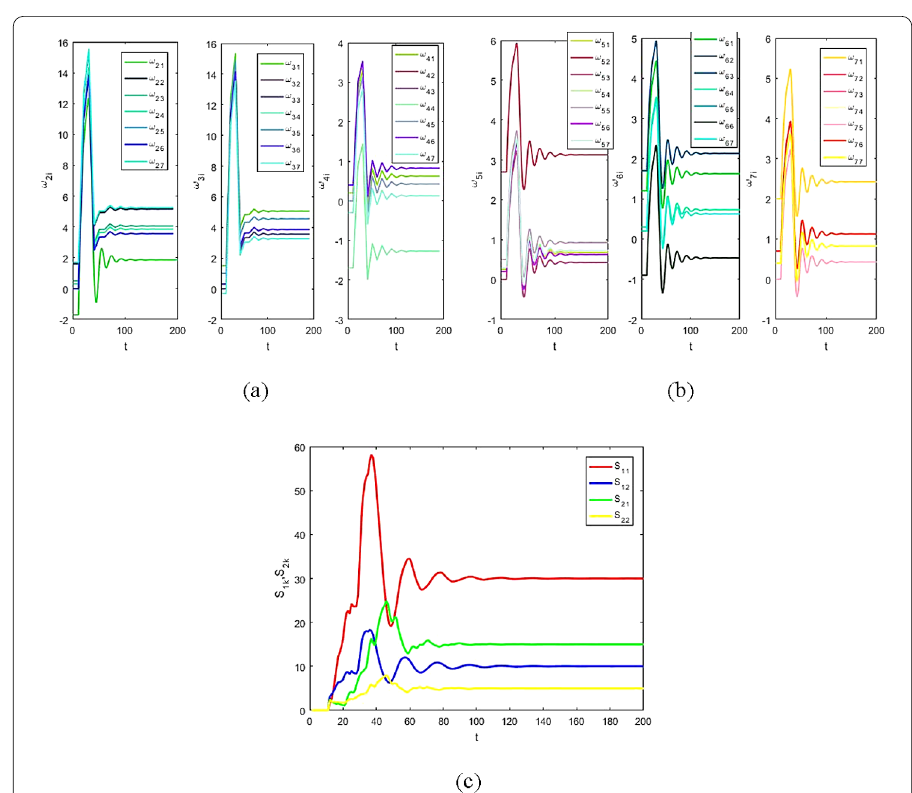
Figure 8 (a) , (b) : Identification process for the adjustment parameter ω ij ( i , j = 2, ... ,7); (c) : state trajectories of S 1 k ( t ) and S 2 k ( t ) ( k =